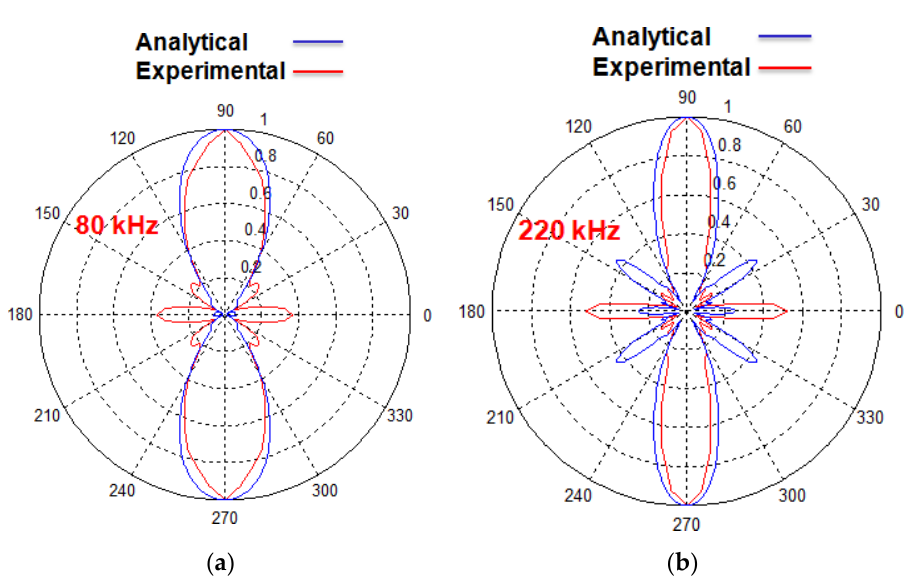
Figure 3. Directivity patterns of the A0 mode of P1-type MFC (28 × 14 mm) transducer at 300 mm distance from the center of a transducer without considering the appropriate wave patterns at 80 kHz ( a ) and 220 kHz ( b ).